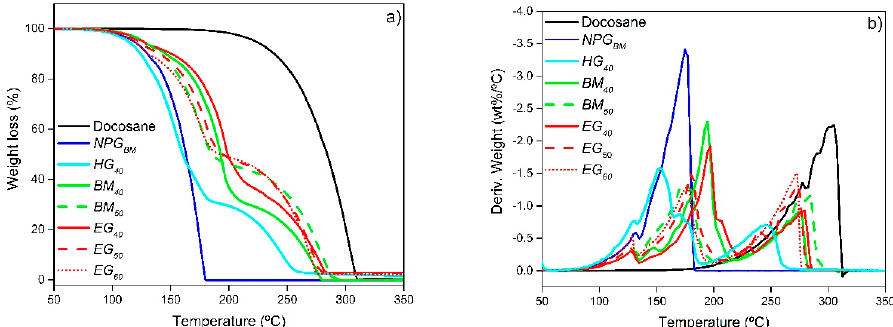
Figure 8. ( a ) TGA and ( b ) DTGA profiles of the samples and their raw